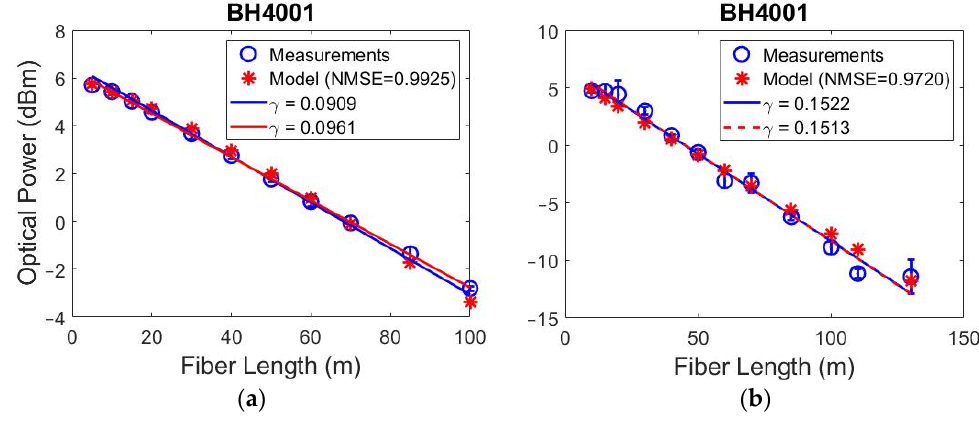
Figure 6. Optical power as a function of the fiber length. ( a ) BH4001 fiber and ( b ) MH4001 fiber.